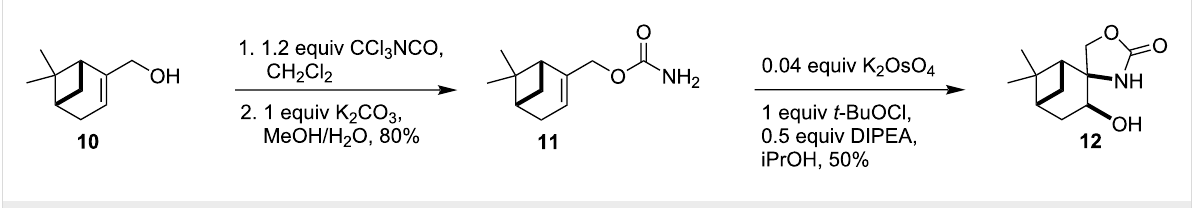
Scheme 2: Stereoselective synthesis of the pinane spiro-fused oxazolidin-2-one 12 .